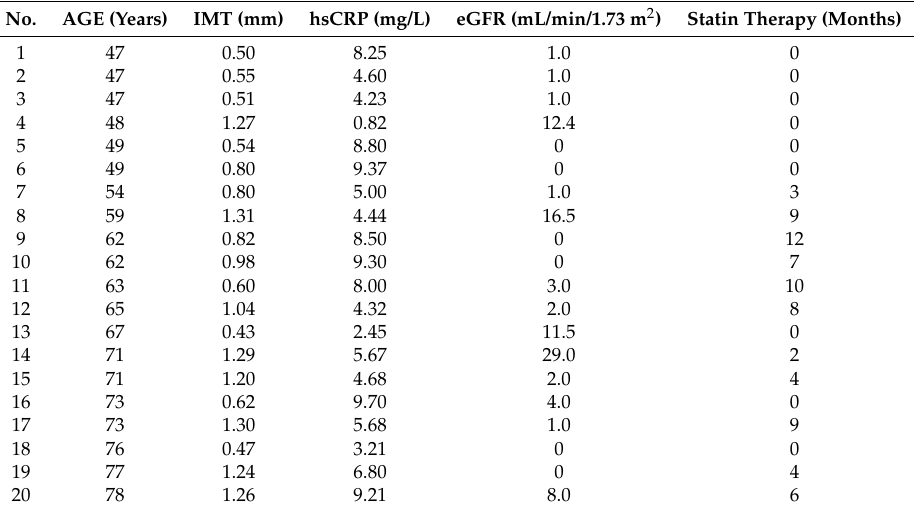
Table A1. Clinical data—hemodialyzed males (CKD5).